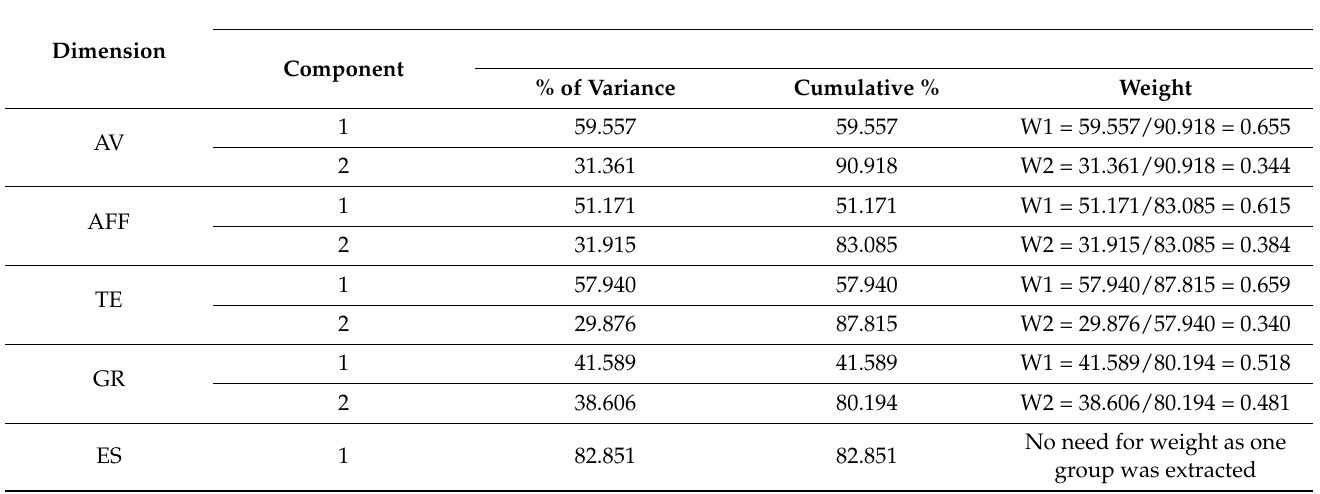
Table 4. Variance-based extraction by PCA. Source: (Author’s own).